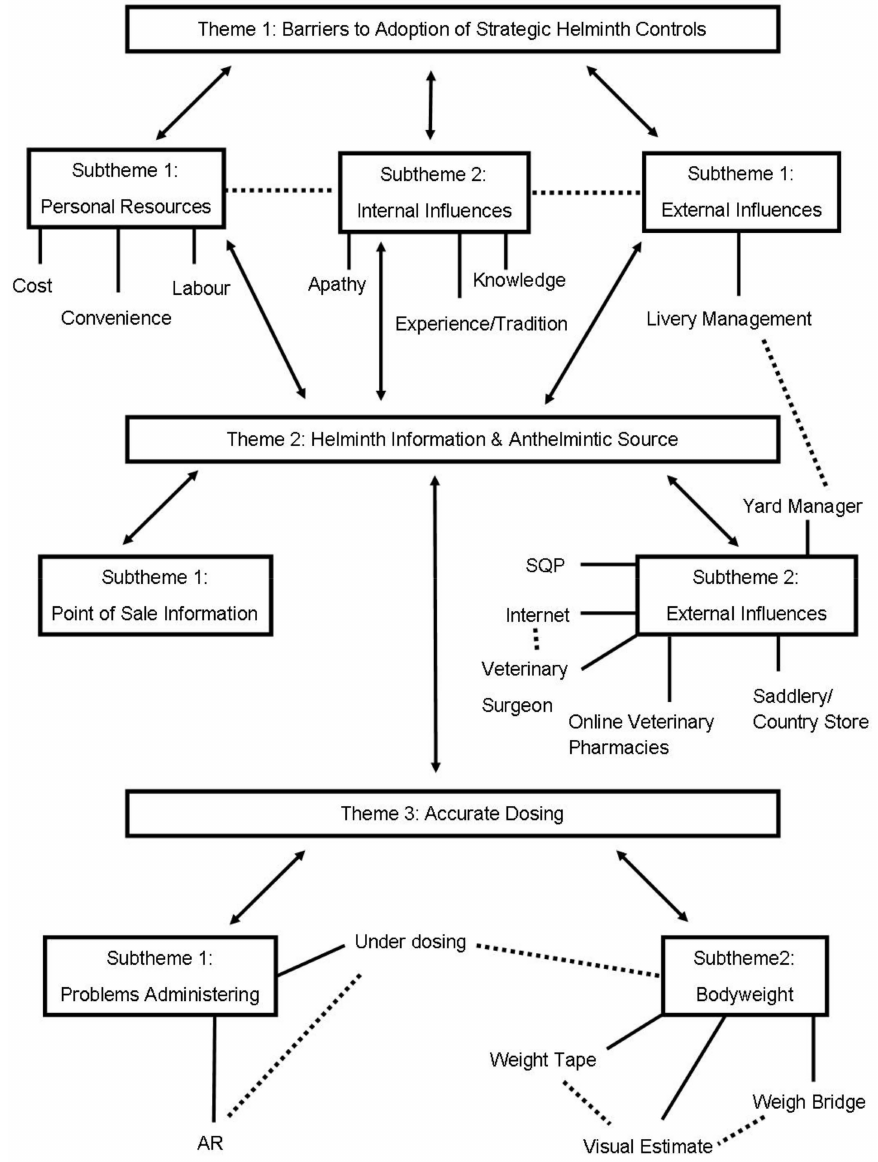
Figure 1. Thematic map illustrating the three main themes, subthemes, and categories, expressing their inter-relationships identified during thematic analysis of 11 semi-structured